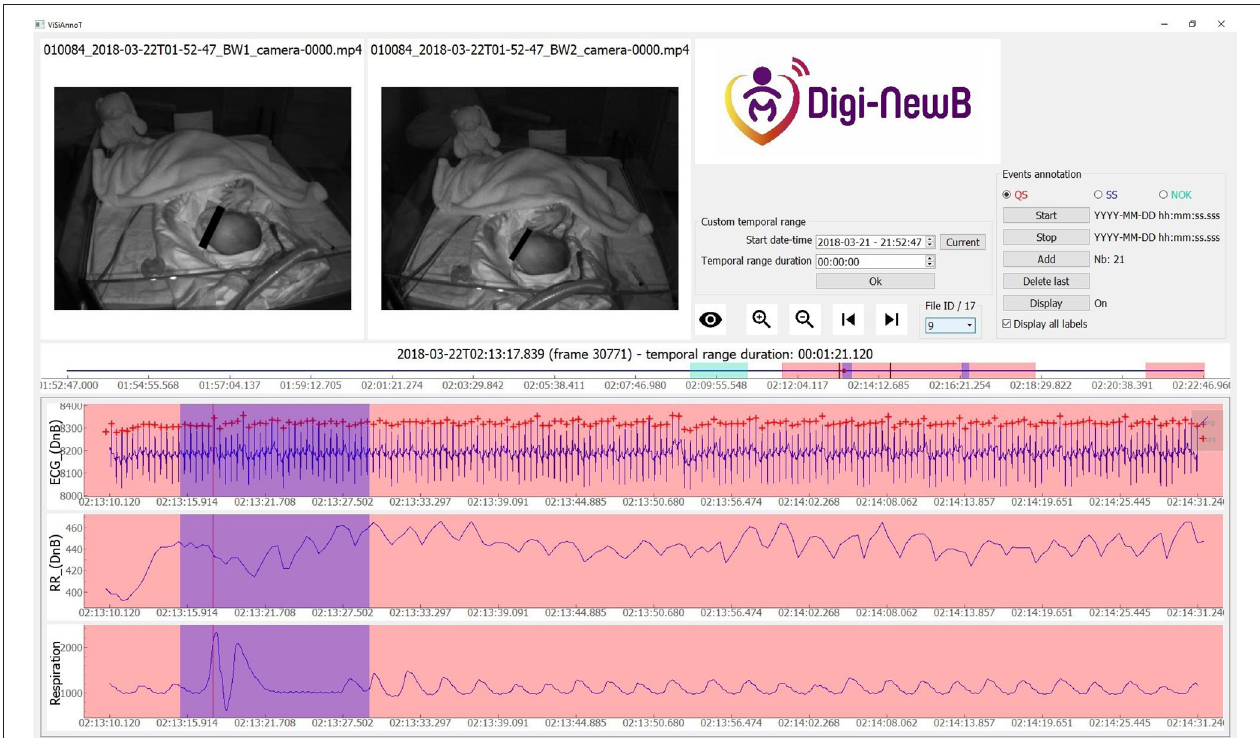
FIGURE 2 | Screenshot of ViSiAnnoT software illustrating a startle in a newborn at 37 + 1 days PMA. There is a short interval of motion (visible in videos) with a modification of respiratory and ECG cycle for startle. The annotated startle intervals are highlighted in